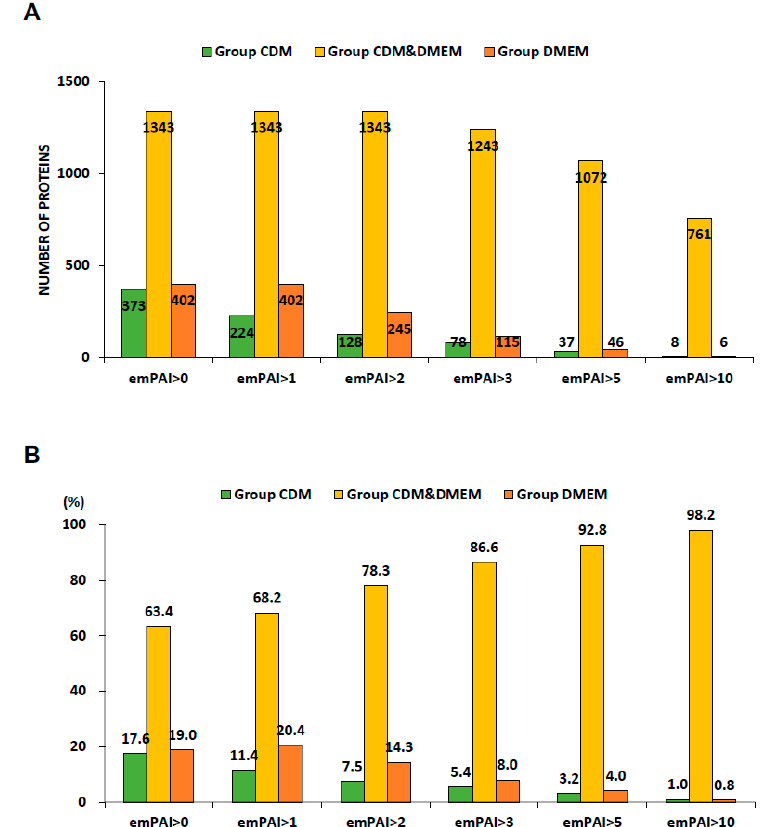
Figure 2. Bar graph of proteins detected on LC-MS/MS. Top panel, there were 1716–769 proteins identified from the CDM hADSCs sample and 1745–767 proteins identified from the DMEM hADSCs (emPAI > 0–10). n = 1 ( A ). Lower panel, 63.4–98.2% of proteins were identified in the CDM & DMEM hADSCs (emPAI > 0–10). n = 1 ( B ).